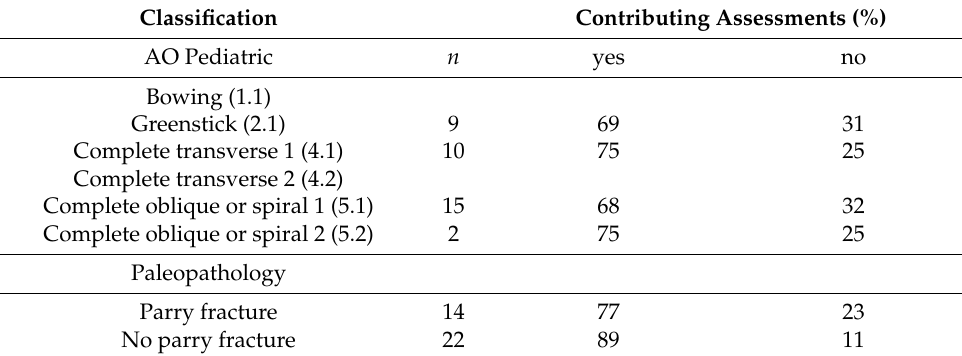
Table 3. Fracture classifications and the contributing assessments.